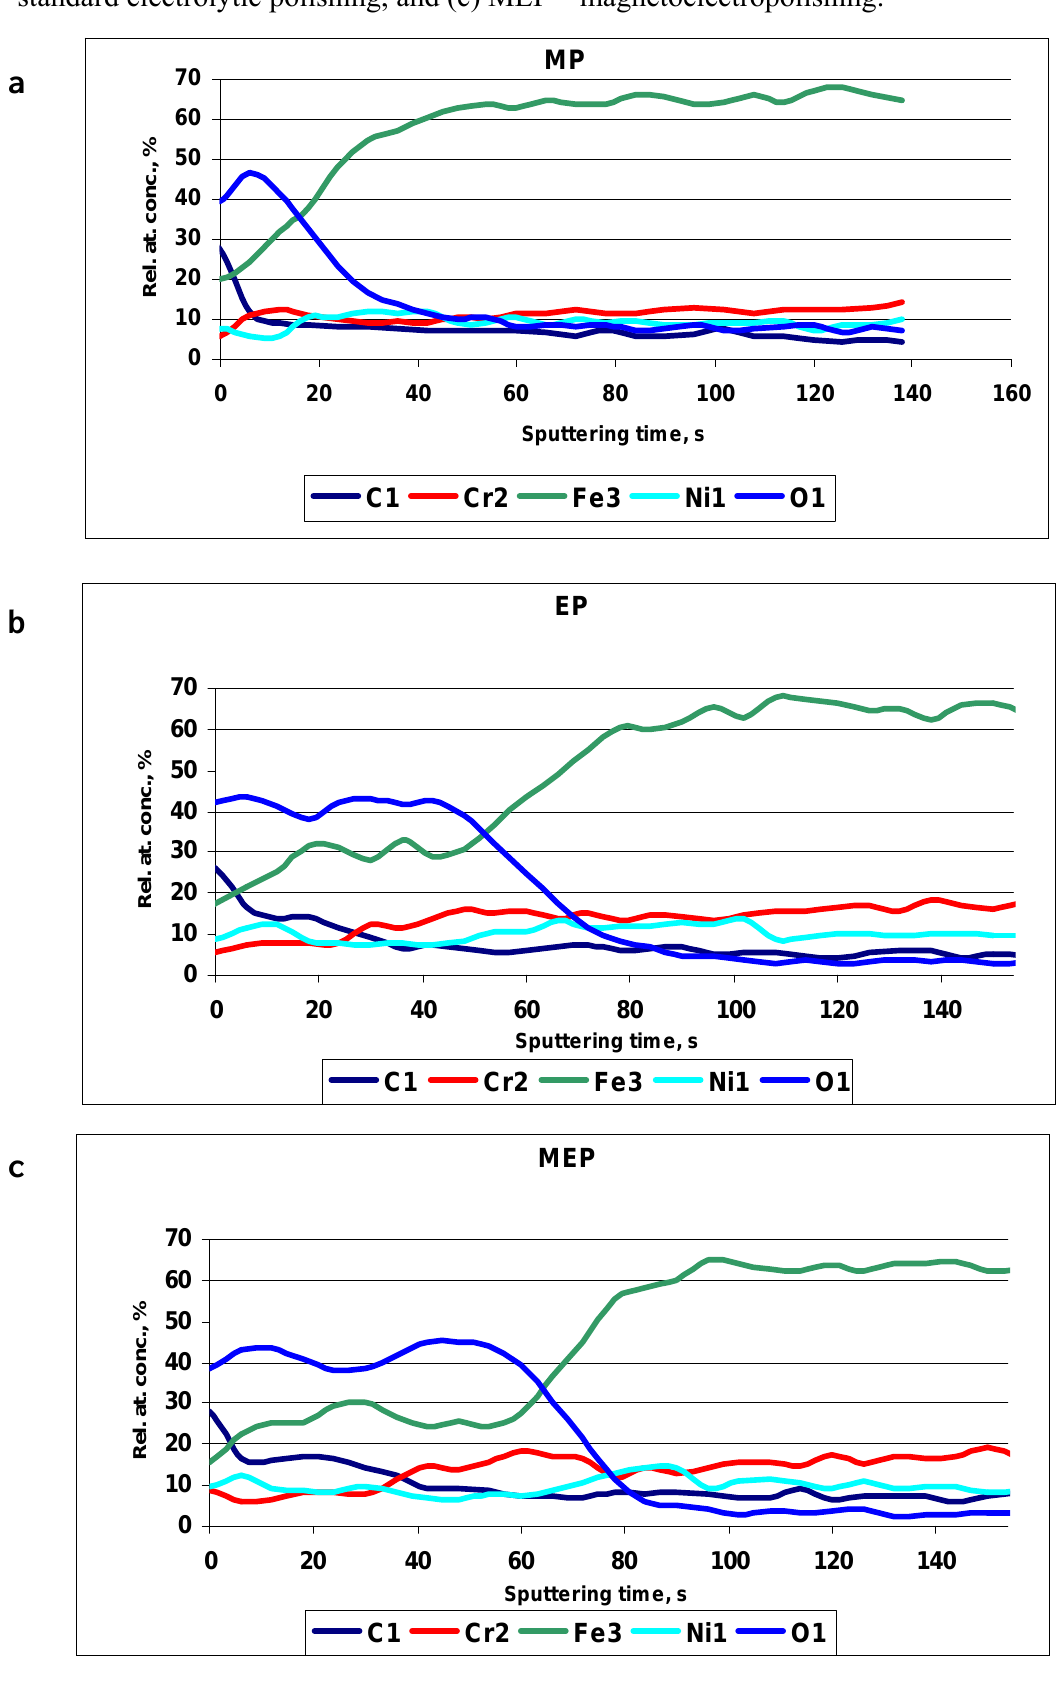
Figure 7. AES results of 316L SS surfaces after: (a) MP – abrasive polishing, (b) EP – standard electrolytic polishing, and (c) MEP – magnetoelectropolishing.